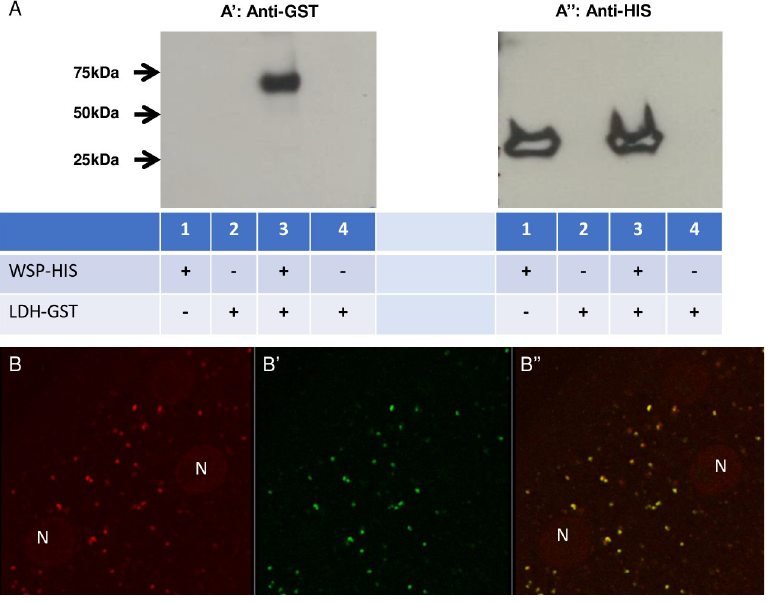
Fig 3. Association of Bm-LDH and wBm0432 of Wolbachia . A. Western blot of the pull-down assay confirming the formation of complexes between wBm0432-HIS and Bm-LDH-GST recombinant proteins. Lane 1, wBm0432-HIS immobilized on Ni-NTA beads (wBm0432-HIS-beads) was incubated with bacterial control extract (bacteria that did not express Bm-LDH-GST). Lane 2, free beads (no proteins were immobilized on the Ni-NTA beads) were incubated with bacterial control extract (bacteria did not express Bm-LDH-GST). Lane 3, wBm0432-HIS-beads were incubated with Bm-LDH-GST within the bacterial extract (bacteria expressing Bm-LDH-GST). Lane 4, free beads were incubated with Bm-LDH-GST within the bacterial extract (bacteria expressed Bm-LDH-GST). Western blot was treated with anti-GST (A’) or with anti-HIS (A”) antibodies. B, B’, B”. Confocal image showing the co-localization of w Bm (red, B) and LDH (green, B’) in the cytoplasm of the parasite’s lateral chord. B”. Merged red and green channels. Colocalization of red and green signals merged as yellow. Magnification 63x. Negative control is presented in S2 Fig .